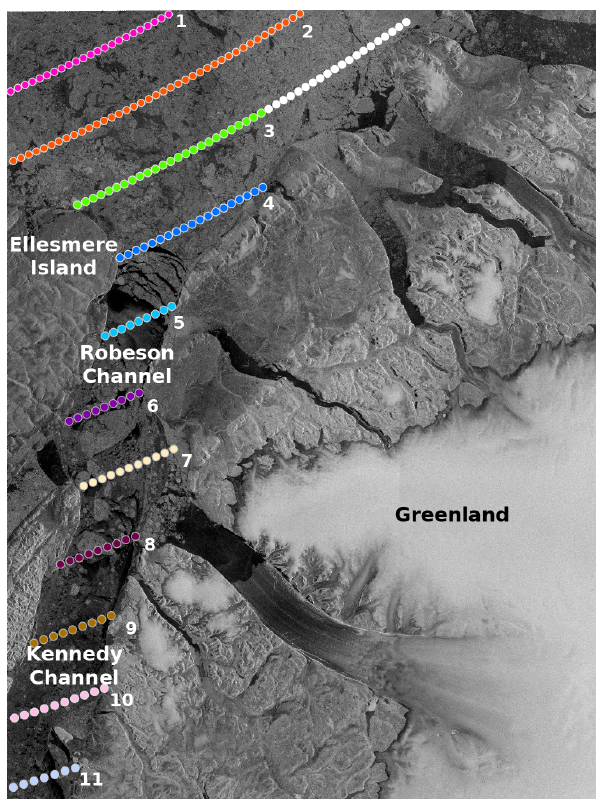
Figure 3. ERA5 grid points of the wind reanalysis data used in the present study. The background is the Sentinel-1B image acquired on 30 January